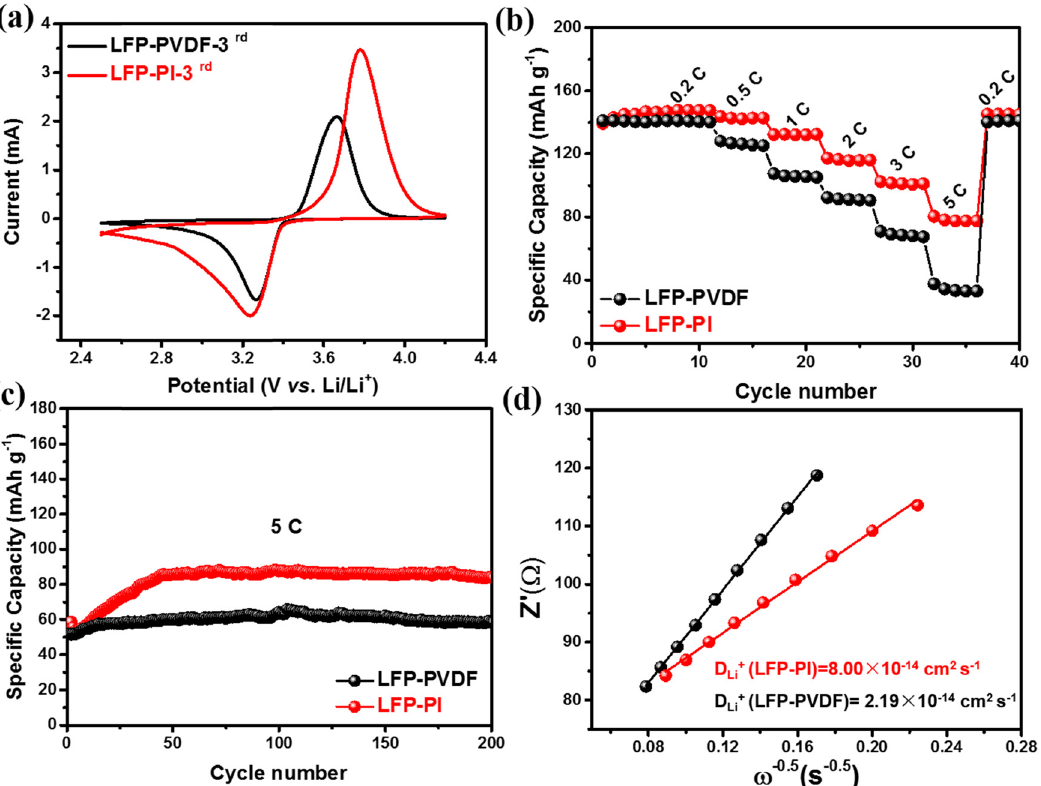
Figure 4: ( a ) CV curves at 1.0 mV S − 1 , ( b ) rate capabilities, ( c ) cycle performances at 5C, and ( d ) Li - ion di ff usion coe ffi cients ( D Li + ) of LFP – PVDF and LFP – PI